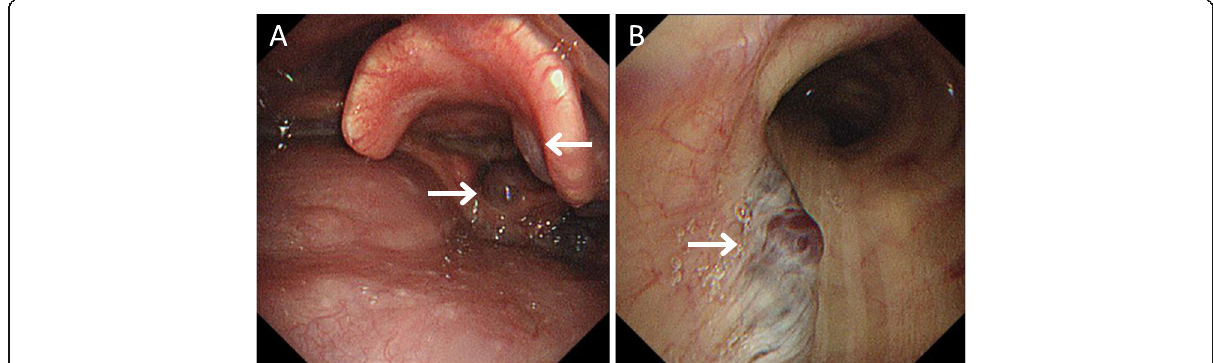
Fig. 2 Fiber optic bronchoscope showing multiple hemangiomas ( a ) at the epiglottic vallecula and arytenoid (white arrows) and ( b ) in the trachea (white